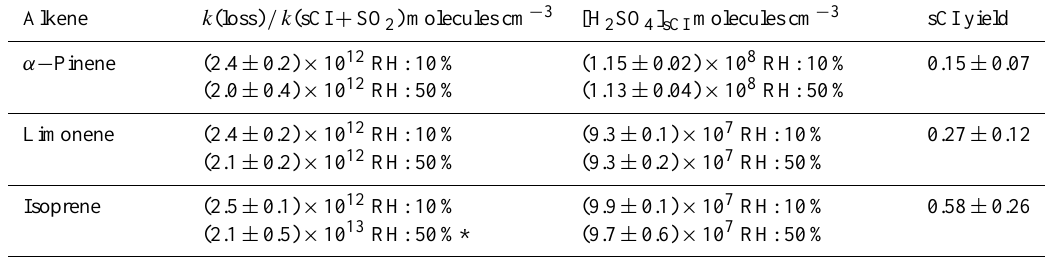
Table 2. Results according to Eqs. (3) and (4) from non-linear regression analysis [H 2 SO 4 ] = f([SO 2 ]). Alkene k (loss) /k (sCI + SO 2 )moleculescm − 3 [H 2 SO 4 ] sCI moleculescm − 3 sCI yield α − Pinene (2.4 ± 0.2) × 10 12 RH: 10%